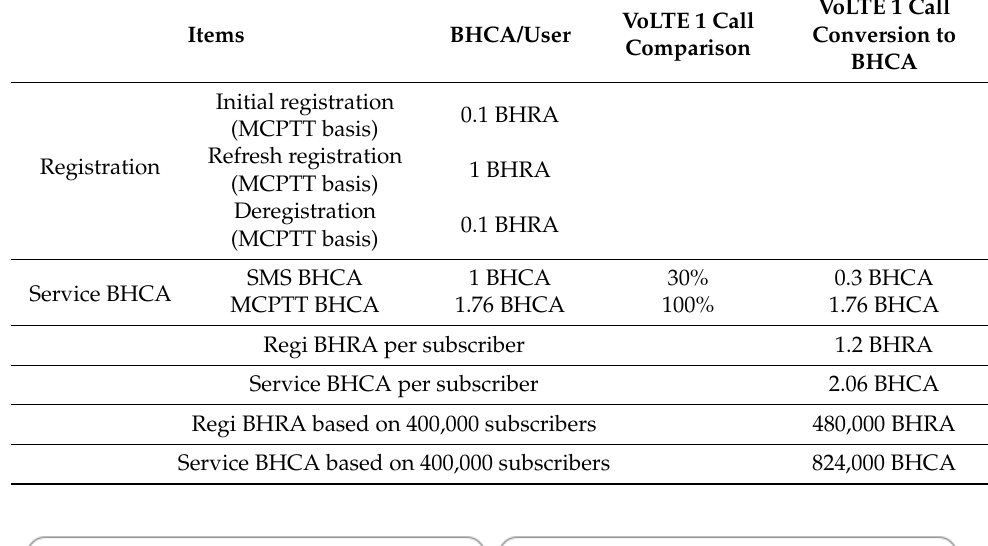
Table 1. MCPTT call model: assuming 400,000 subscriber base.